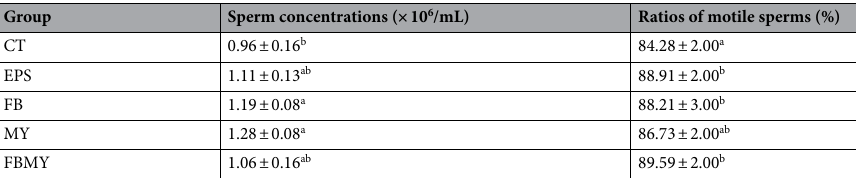
Table 2. Effects of C. militaris fermentation products on sperm parameters in epididymis of JM mice. *Values are presented as means ± SD (n = 5 for all test groups). Panels marked with different lowercase letters are significantly different ( p < 0.05).